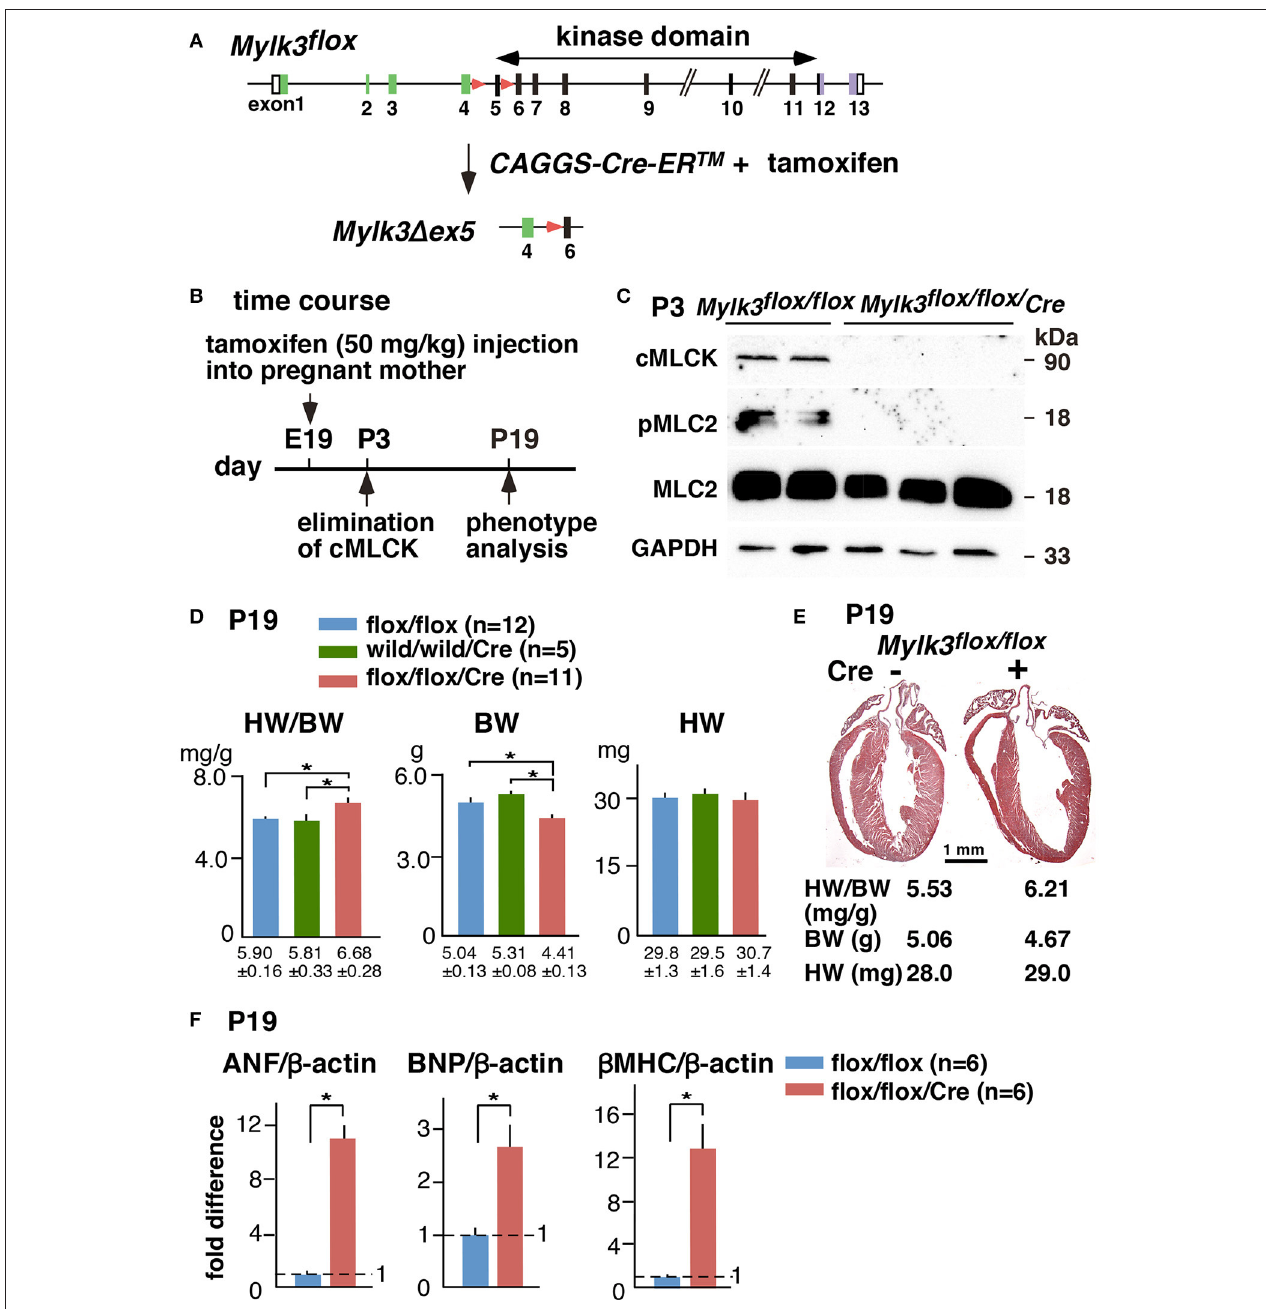
FIGURE 1 | Experimental design of perinatal inducible Mylk3-KO mice leading to acute heart failure. (A) Strategy for cardiac tamoxifen-inducible perinatal Mylk3-KO . (B) Timeline of experiments. (C) Western blotting demonstrates the expression of cMLCK and MLC2 phosphorylation 3 days after tamoxifen-injection in Mylk3 flox / flox with or without the CAGGS-Cre-ER TM transgene. (D) Heart weight/body weight (HW/BW) ratio, body weight (BW), and heart weight (HW) of Mylk3 flox / flox / Tg-CAGGS-Cre-ER TM compared to two controls, Mylk3 flox / flox and Mylk3 wild / wild / Tg-CAGGS-Cre-ER TM . (E) Representative sagittal sections of the heart between control (Cre-) and Mylk3 KO (Cre + ) at P19. Bar = 1mm. (F) Real-time RT-PCR shows fold differences in mRNA of ANF, BNP, and β -MHC relative to β -actin with the value in Mylk3 flox / flox defined as 1 (mean ± SE). * p < 0.05 using ANOVA for Panel (D) and T -test for Panel (F) .